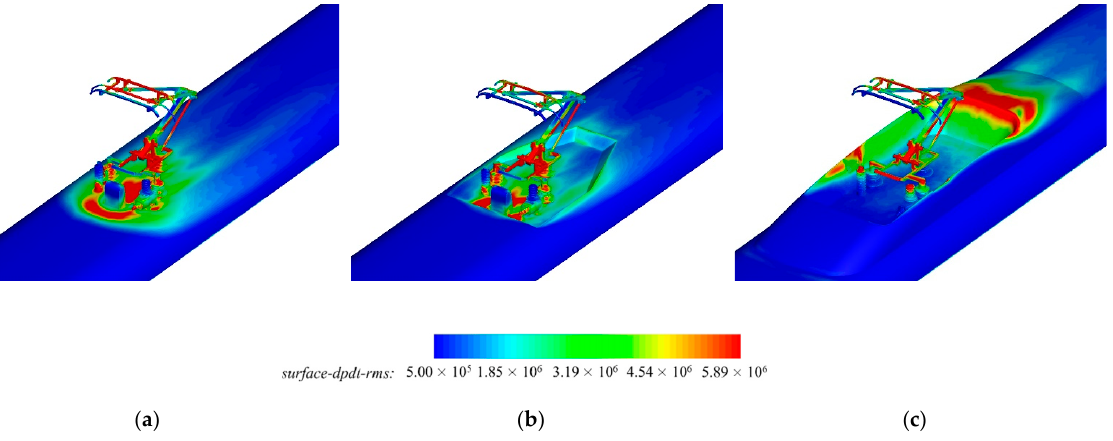
Figure 10. Pressure fluctuation of the computational models. ( a ) Case 1; ( b ) case 2; ( c ) case 3.